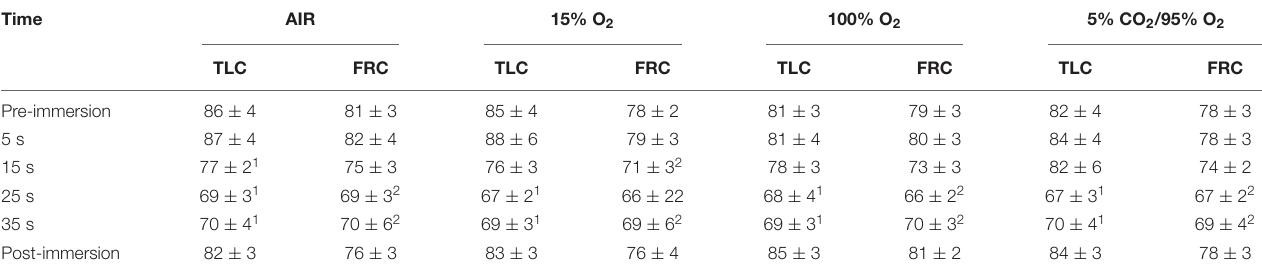
TABLE 1 | Chemoreceptor stimulation by breathing different gases before face immersion did not affect the HR response (presented as HR ± SE) to face immersion. Time